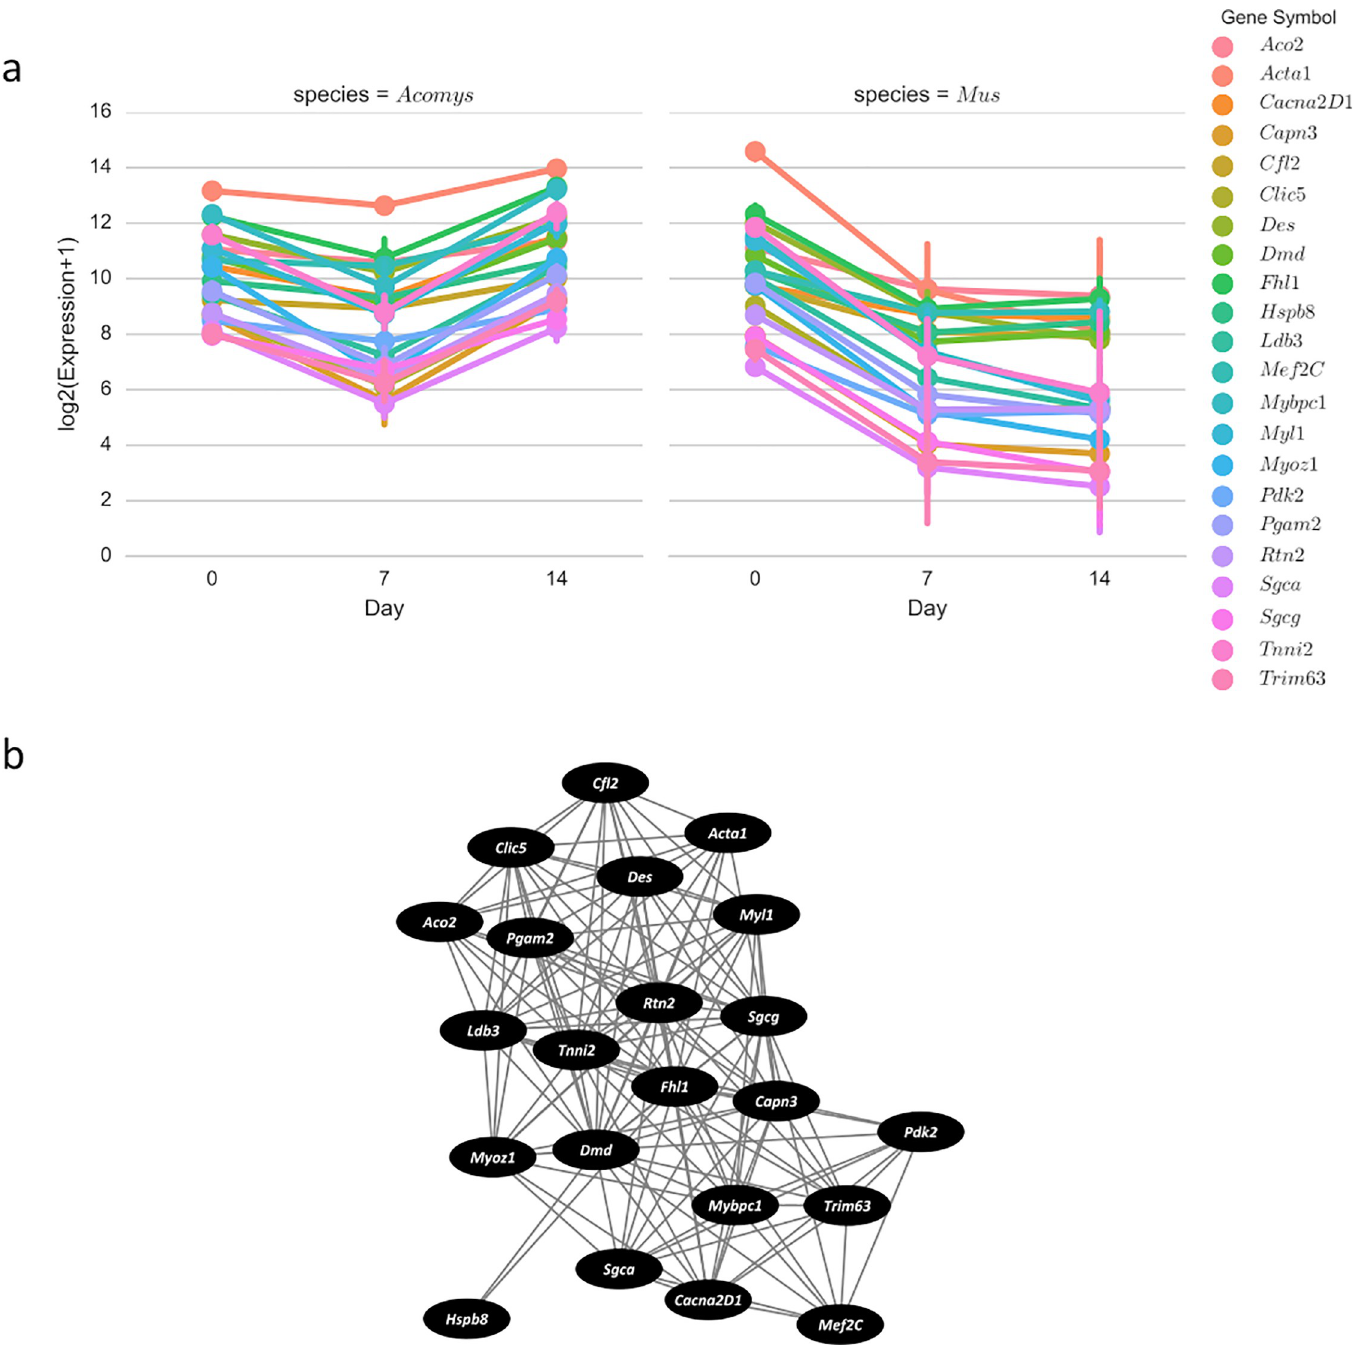
Fig 2. Dmd demonstrates co-expression with numerous muscle-related genes. a) Factor plot showing log 2 (RNA-Seq expression + 1) across samples with bars representing 95% confidence intervals. All co-expressed genes are significantly differentially expressed between days 0 and 14 in the combined analysis and represent regulators or regulator targets identified by IPA. b) Dmd and co-expressed genes in a network where edges represent a correlation of 0.914 or